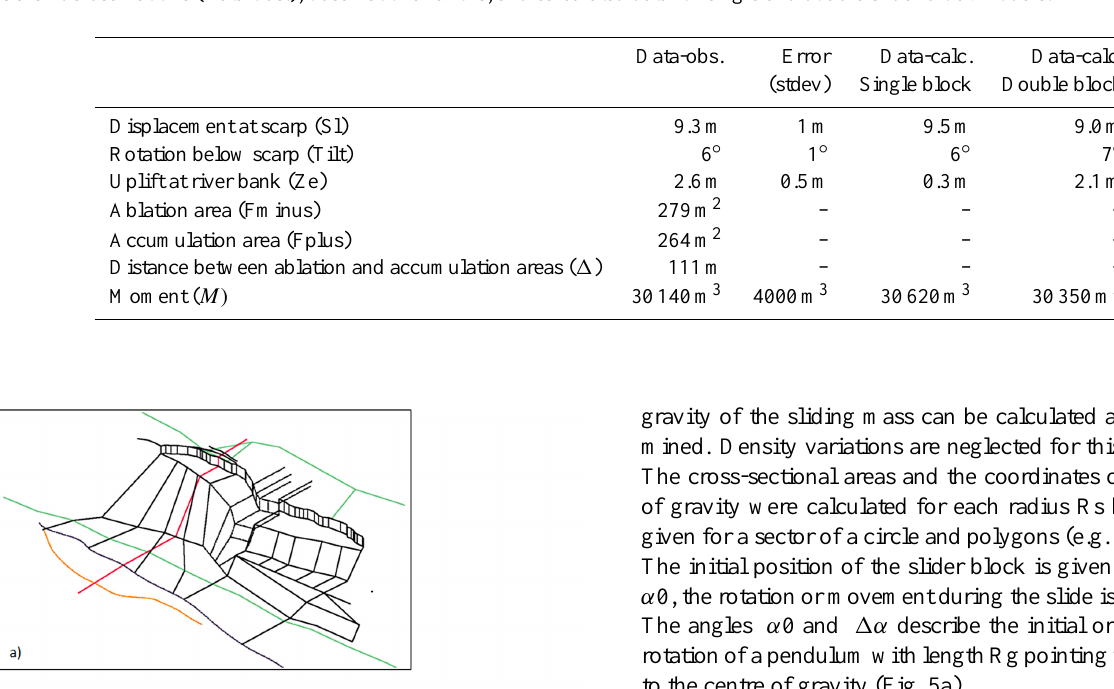
Table 1. Observations (Data-obs.), observational errors, and calculated data for single and double slider block models.